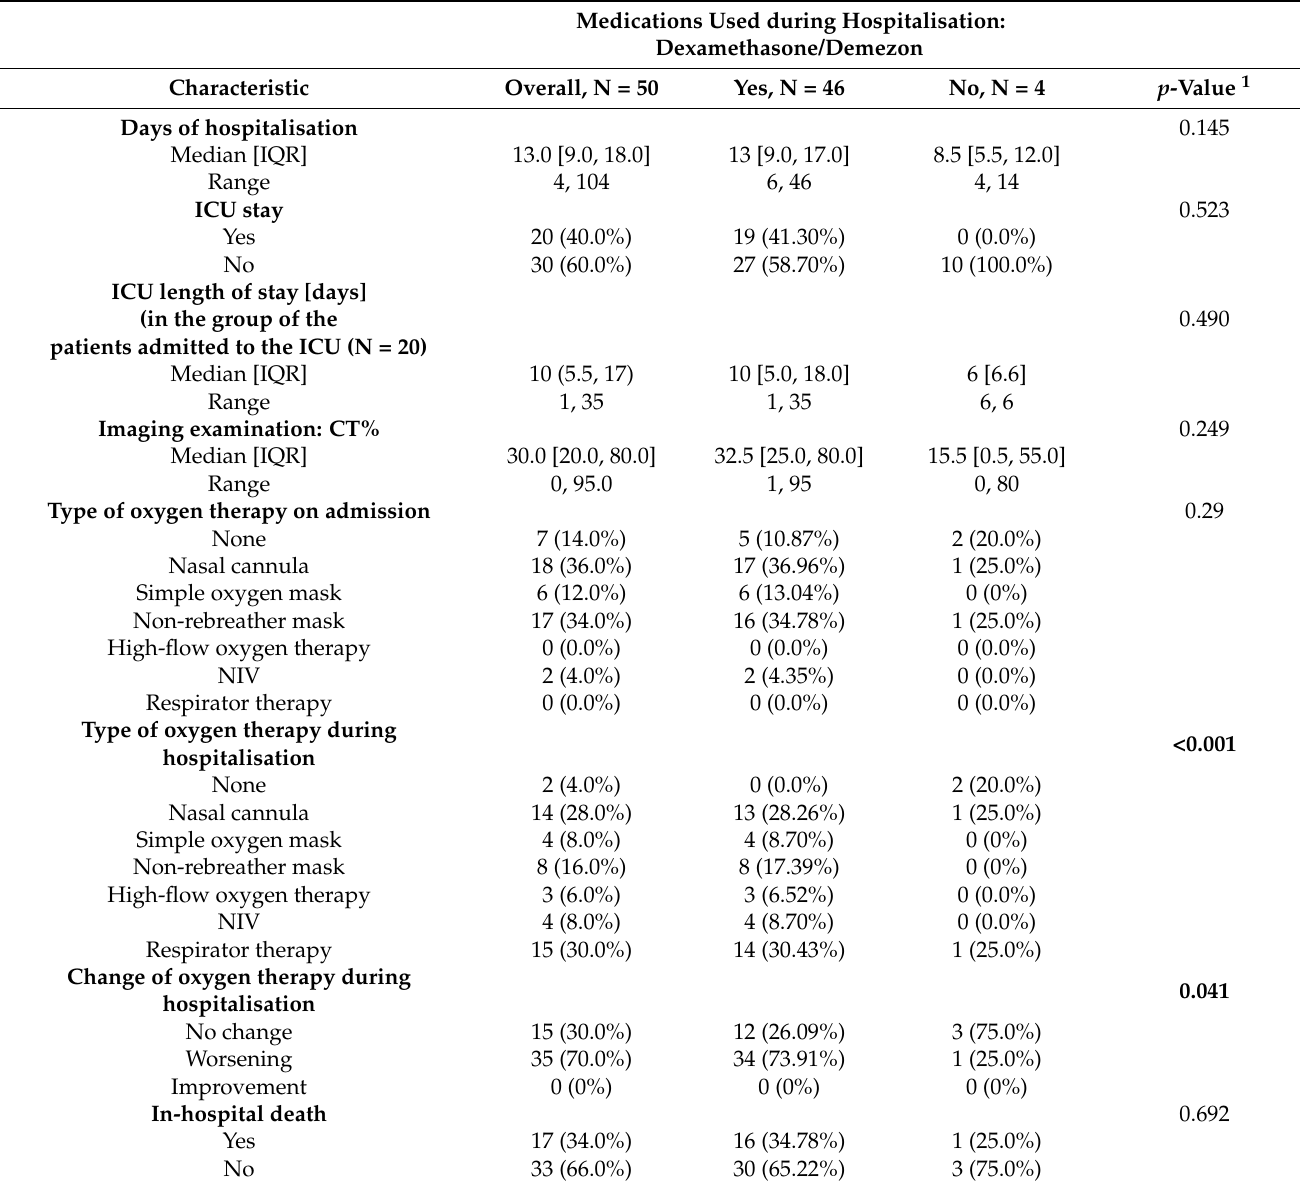
Table 7. Severity of COVID-19 vs. dexamethasone medication, comparison between groups. Medications Used during